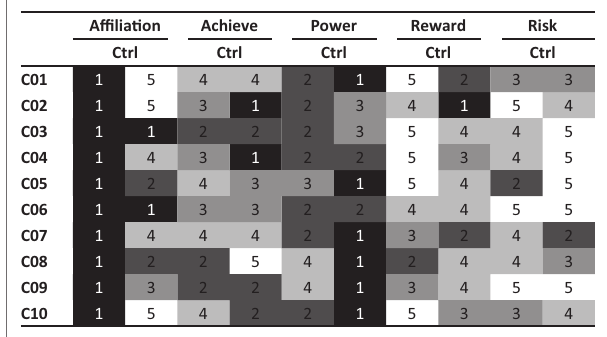
FIGURE 2: Drive dimension